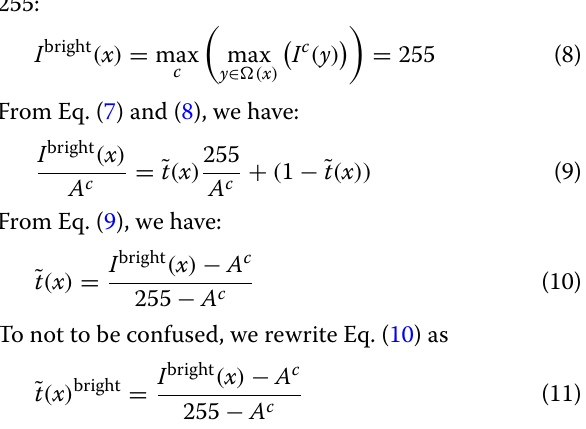
light. For example, in a real low illumination image, if there exists brighter lights such as lamp light or moon light